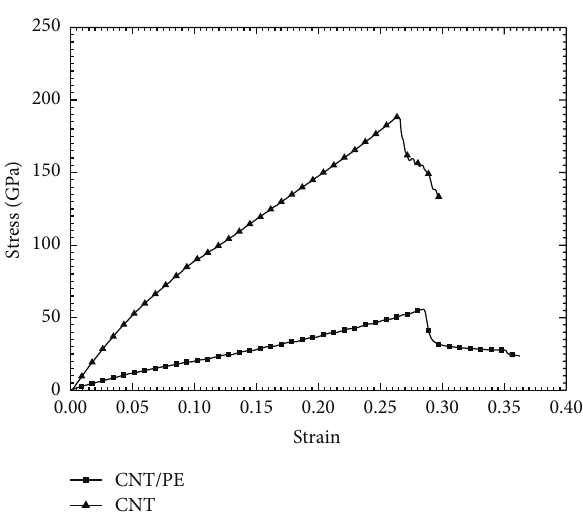
Figure 10: Tensile stress-strain curves of CNT/PE composite.